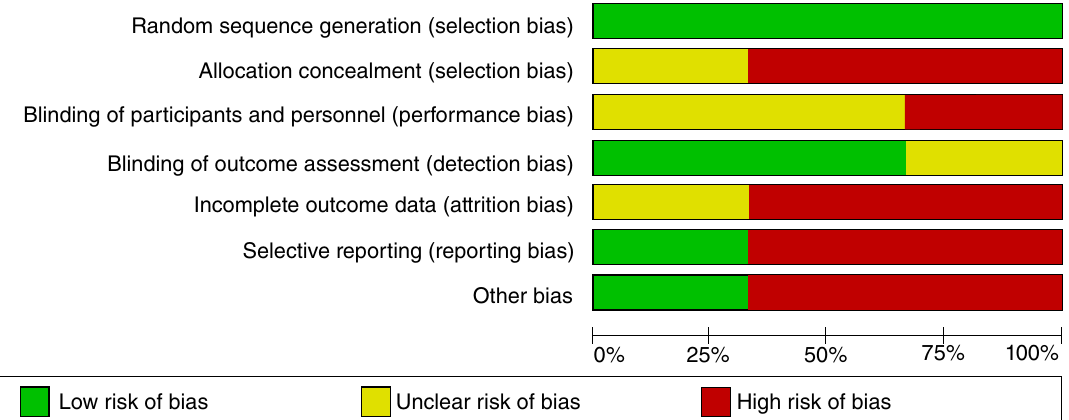
with a diagnosis of either post-traumatic SNAC or SLAC (10 patients in each group). The 4CF group did have significantly greater grip strength than the PRC group on the affected side pre-operatively and this persisted post-operatively. Unfortunately, it was not possible to obtain further data from the authors to enable a more detailed